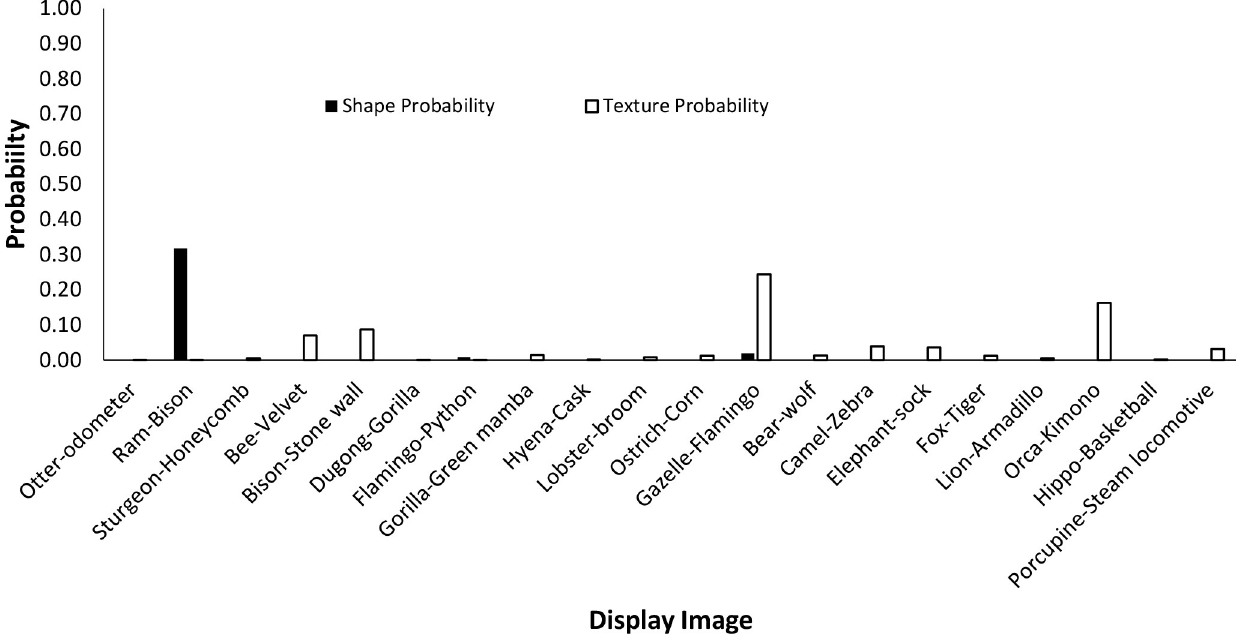
Fig 7. Comparison of probabilities assigned to image shapes and textures for animals. On the x-axis, the shape and texture of each object are given as shape-texture. Filled black bars display the probability given by the network to the correct shape. Outlined bars display the probability given by the network for the correct